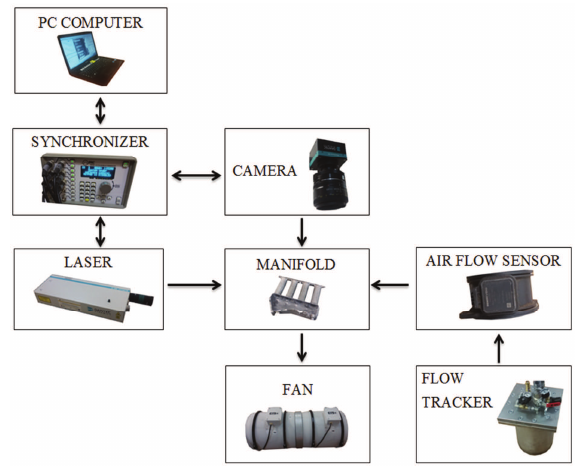
Fig. 7. Scheme of experimental setup